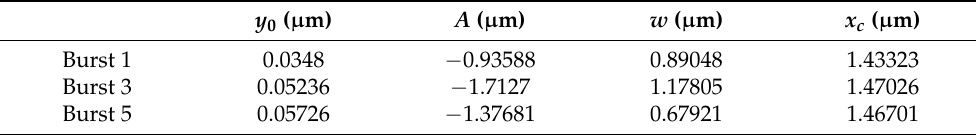
Table 1. The parameters of the fitted profile of the ARMs’ craters in three burst modes.